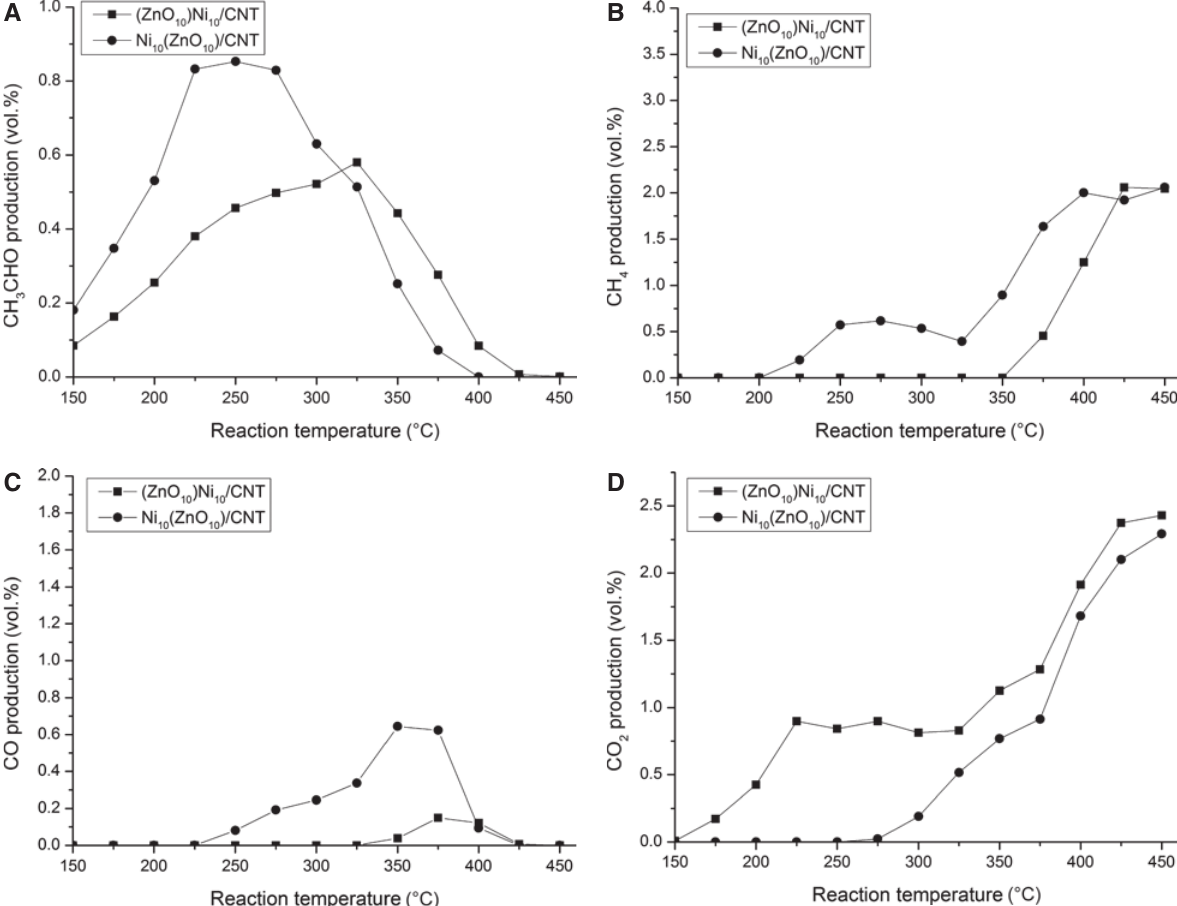
CHO, (B) CH , (C) CO and (D) CO 3 4